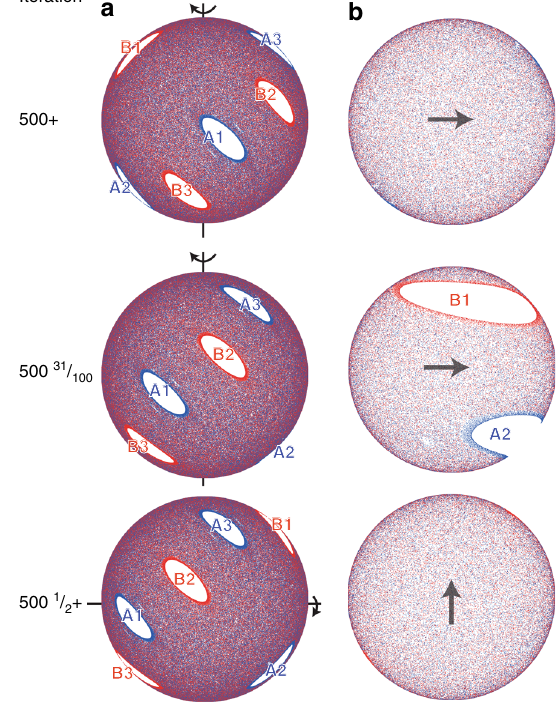
layer. Non-mixing regions (A1-A3, B1-B3) present at ϵ = 0 [see Fig. 7a] are still present at ϵ = 0.15 and pass fully through the fl owing layer after each half-iteration [(57°, 57°) protocol]. Views from below of a the hemispherical shell and b the planar fl owing layer. Labels of periodic regions illustrate changes in orientation and arrows indicate the direction of fl ow in the fl owing layer. Animations are provided in Supplementary Movie